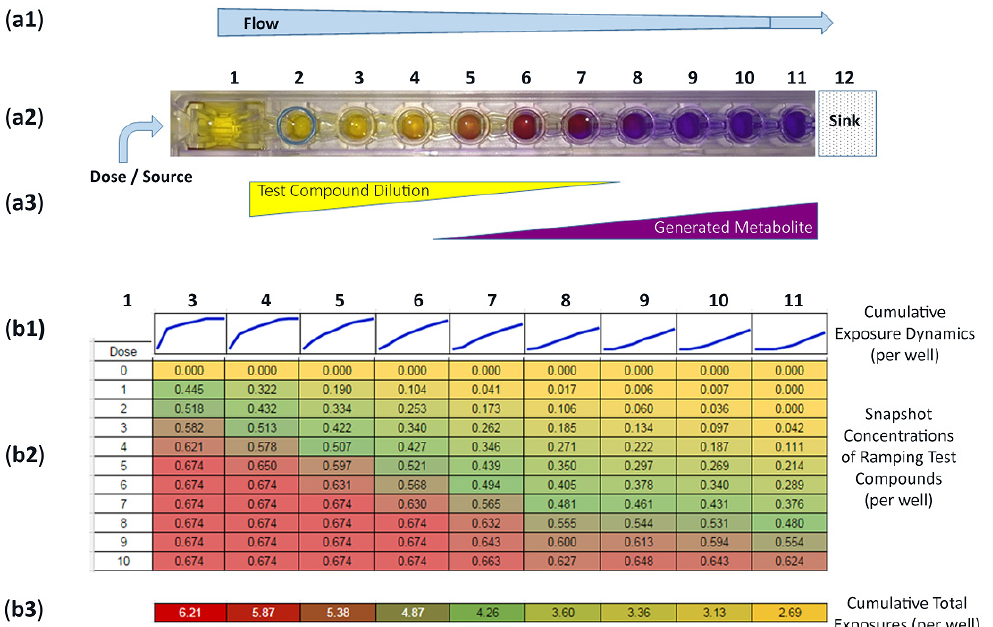
Figure 4. Operational insights. ( a ) Top view simulation of one microfluidic channel signifying dual exposure gradients of test compound (dosed into well 1) and cell generated metabolite. ( b ) Modulating experimental exposures of test compound throughout one device row having ten (10) re-doses of 100 µL over 3 days. Values 0 → 1 equate to 0 → 100% of dose. Dose “0” is culture media without compound (i.e., no-dose baseline). ( b1 ) Linescans displaying a timeline of aggregate exposure kinetics, per well, with compound exposure traits ranging from asymptotic (wells 3, 4), approximately linear (wells 7, 8), and delayed increase (lag of exposures in wells 10, 11). Subsequently, fully developed linescans progress into natural logarithm, linear, and delayed exponential growth [23]. ( b2 ) Well-specific, data centric, cumulative exposures over time (i.e., area under curve); similar to a radiation model. The final equilibrium drug concentration is very similar across the entire plate (dose 10; wells 3–11; 67.4 → 62.4%). ( b3 ) Total “Cumulative Exposure” is very different in each well, 6.21 → 2.69.